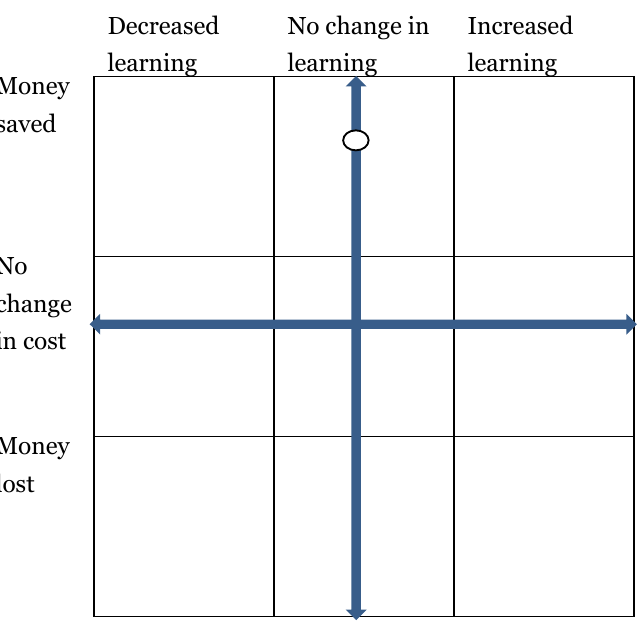
Figure 2. Outcomes in cost and education in the present